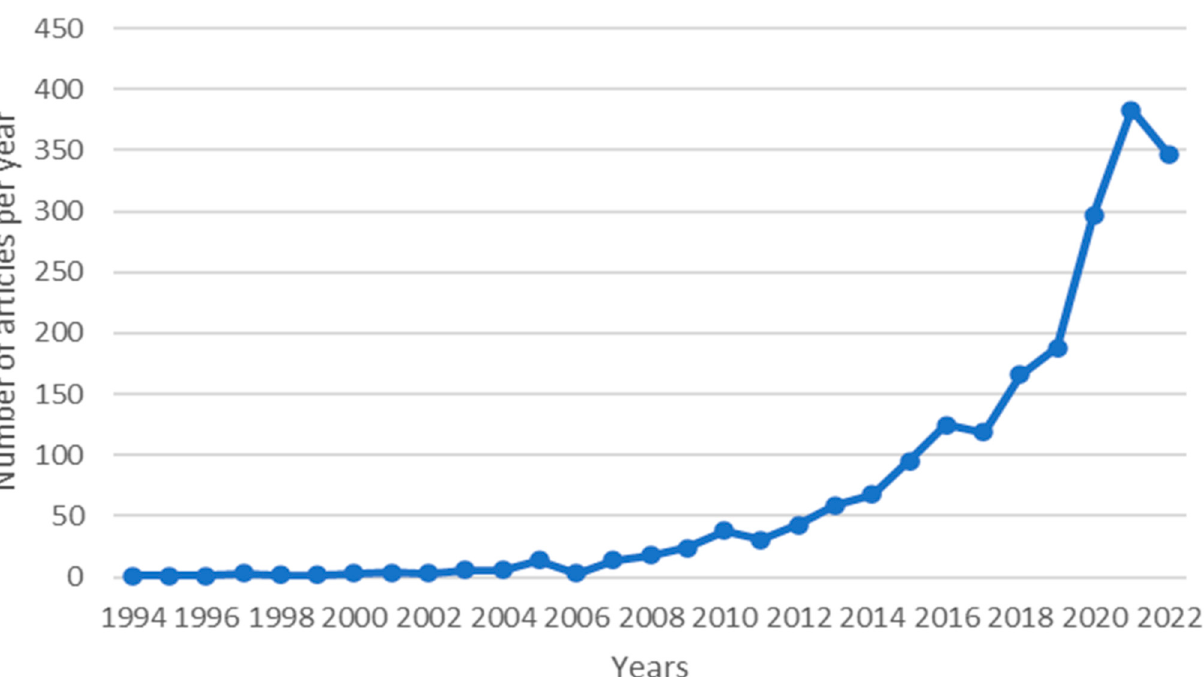
Figure 2. Evolution of production over time .